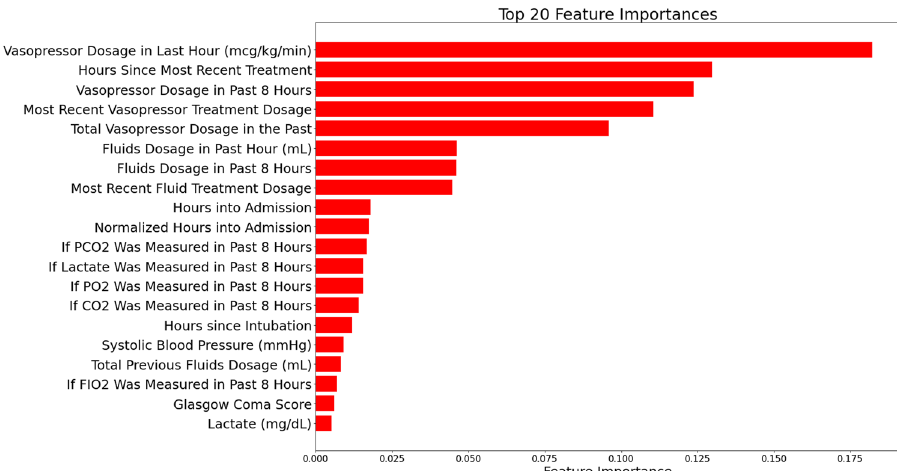
Fig. 6 Feature importance of clinical variables. Bar charts showing feature importance, derived from random forest classi fi ers, in descending